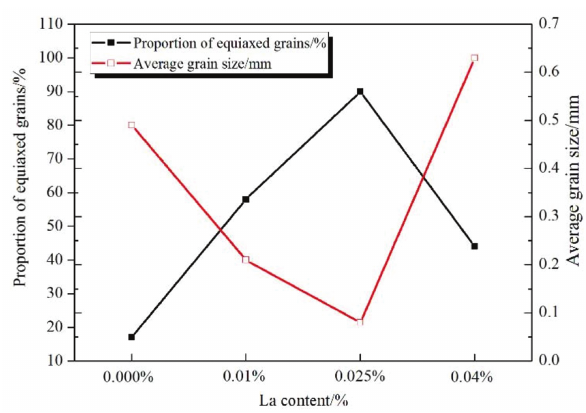
Figure 3: Relationship between lanthanum contents and character- istic parameters of the macrostructures.